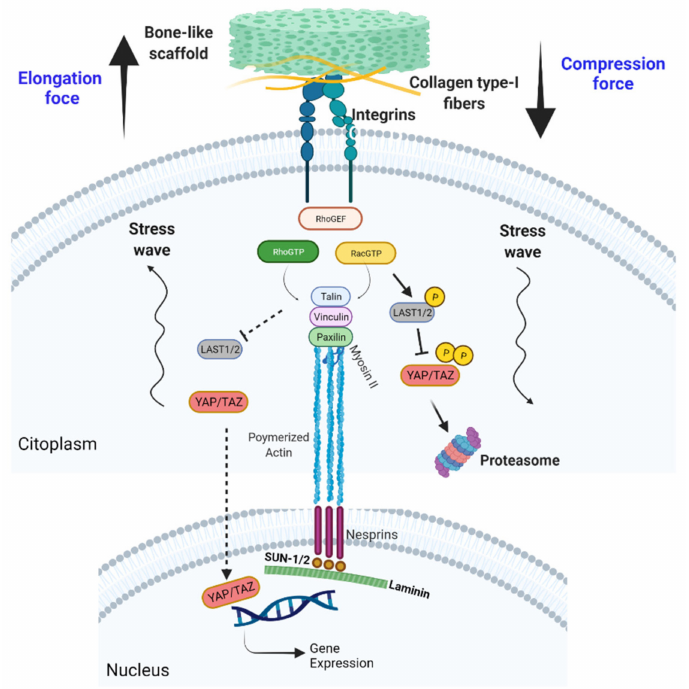
Figure 3. Canonical signaling pathway during cell–ECM interaction with a bone-like scaffold. Mechanical deformation induced by elongation and compression forces triggers recruitment of focal adhesion proteins (vinculin, talin, and paxillin). Focal adhesion kinase (FAK) proteins induce polymerization of actin from the cell cytoskeleton, transmitting the deformation cue to the nucleus cytoskeleton. In parallel, YAP/TAZ molecules are translocated to the nucleus in a mechanical- dependent manner, controlling the expression of genes implicated in proliferation and